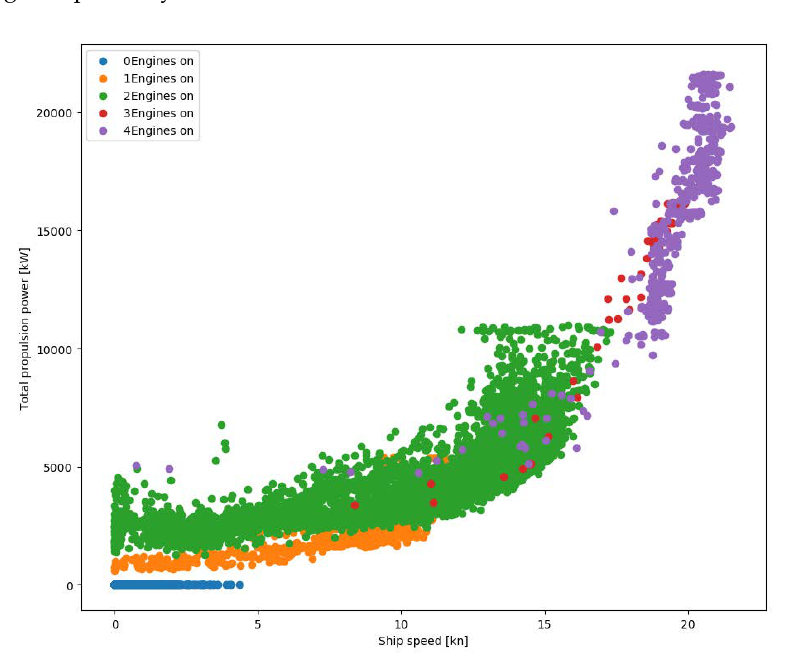
Figure A1. Scatter plot, Propulsion power versus ship